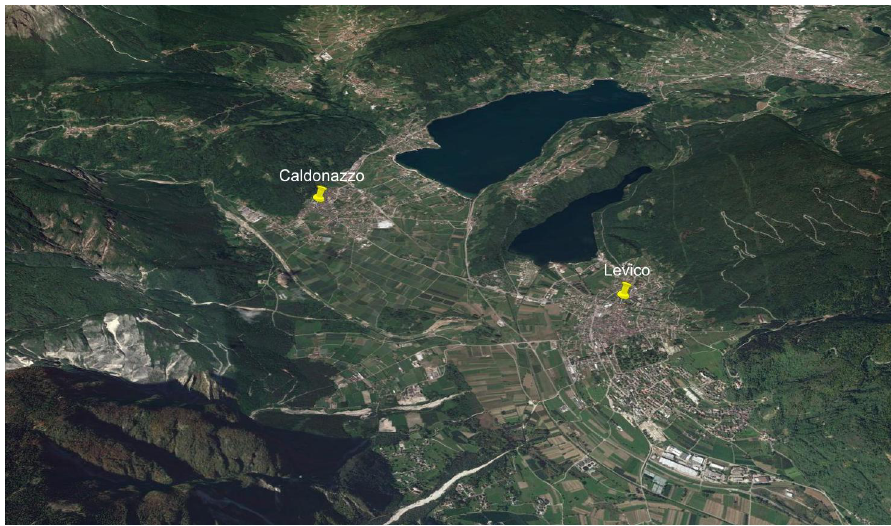
Figure 9. Caldonazzo and Levico geographical position view; geodesic distance of about 4.60 km.